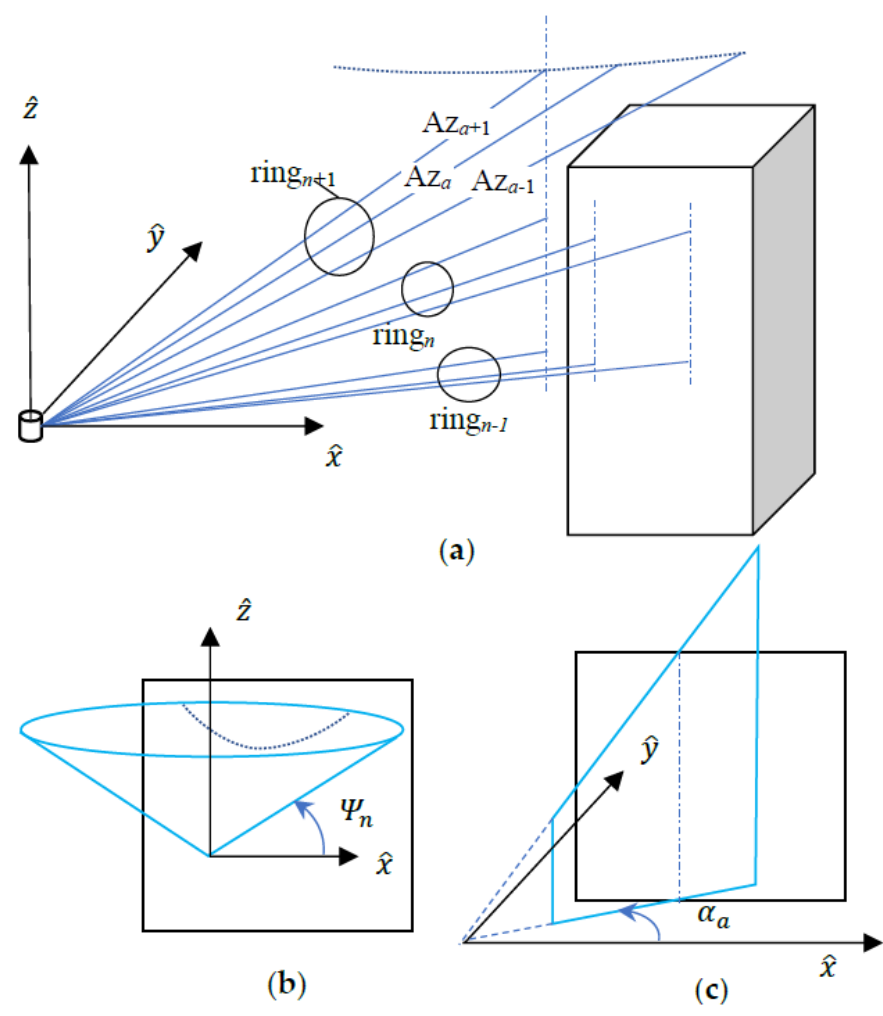
Figure 1. LiDAR data points: ( a ) on different walls, ( b ) ring projection, and ( c ) azimuth projection.